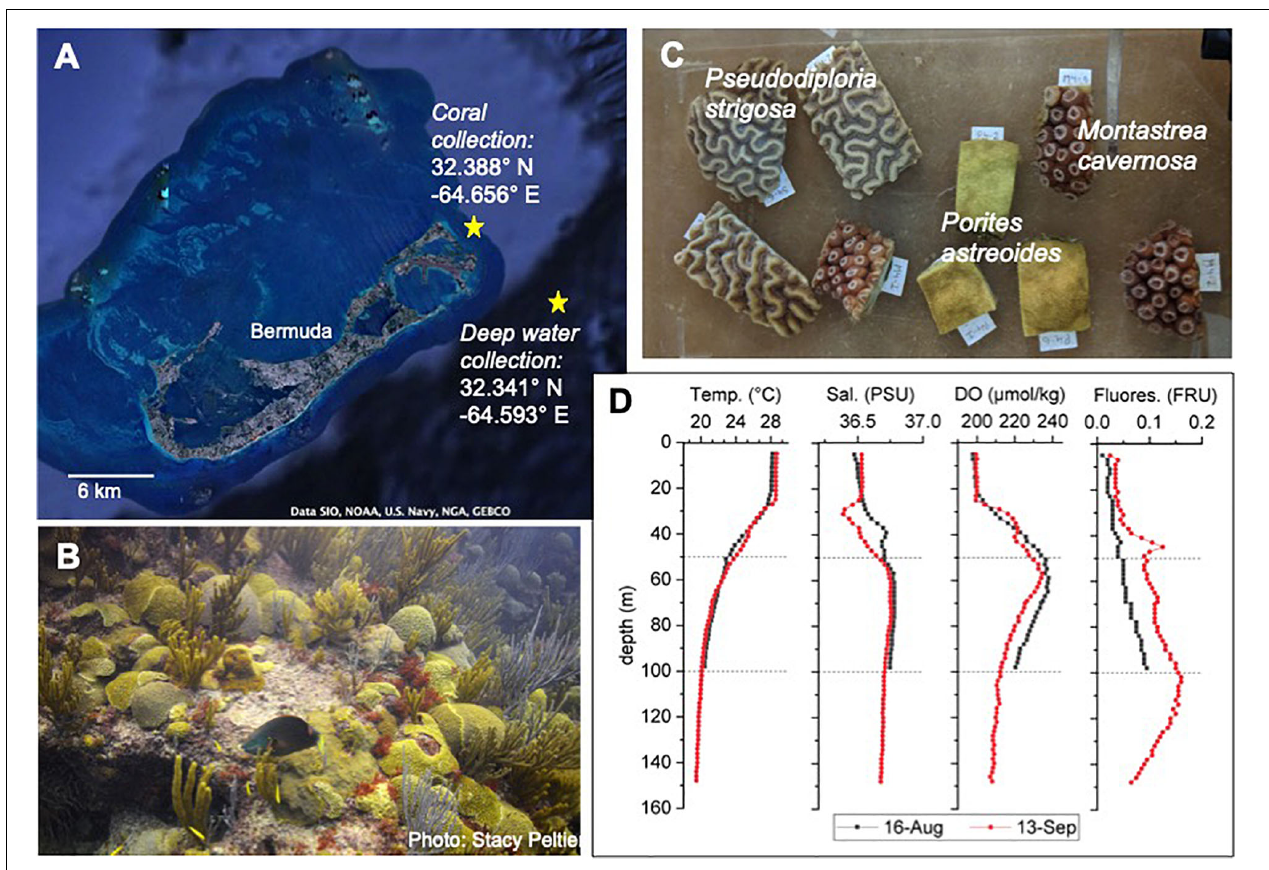
FIGURE 1 | Overview of study site and species. (A) Google Earth image of Bermuda and the Bermuda platform with extensive coral reefs at the edges of the platform and at places throughout the platform. Site of coral collection and of deep-water collection are indicated by yellow stars. (B) Typical benthic community of a shallow water coral reef in Bermuda. (C) Coral fragments cut from coral colonies for the experiment. (D) Depth profiles at the site of water collection on 16-August and 13-September 2018. Temp., temperature; Sal., salinity; DO, dissolved oxygen; Fluores., fluorescence in fluorescence relative units (RFU). Calibrated data for the depth profiles provided by the Dr. Rod Johnson as part of the Bermuda Atlantic Time Series